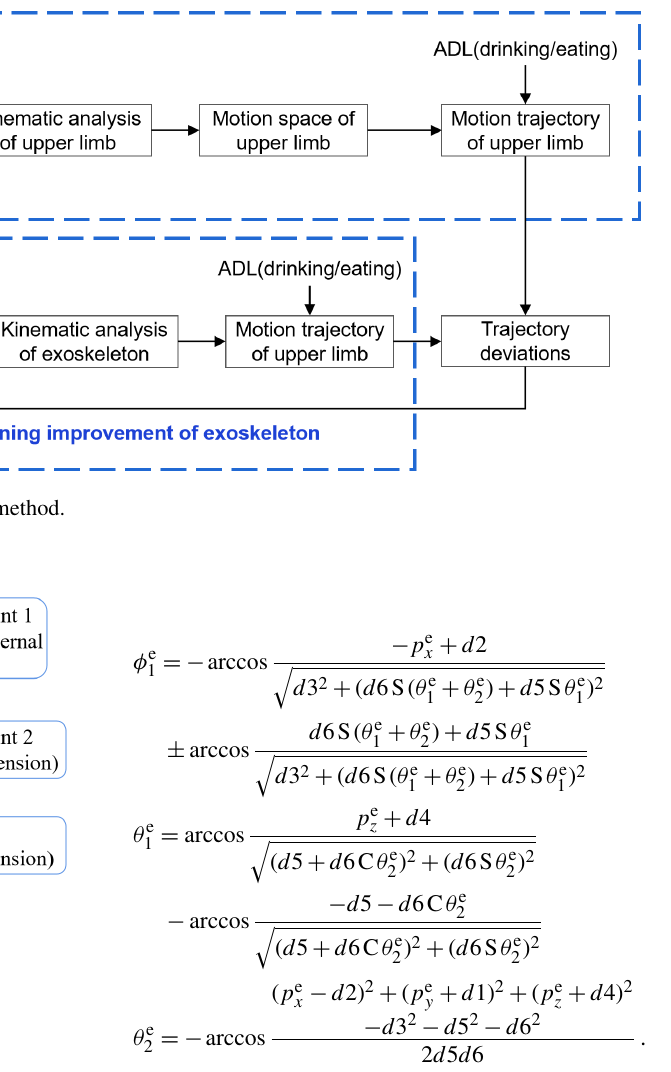
Figure 12. The prototype of an upper limb exoskeleton robot based on a